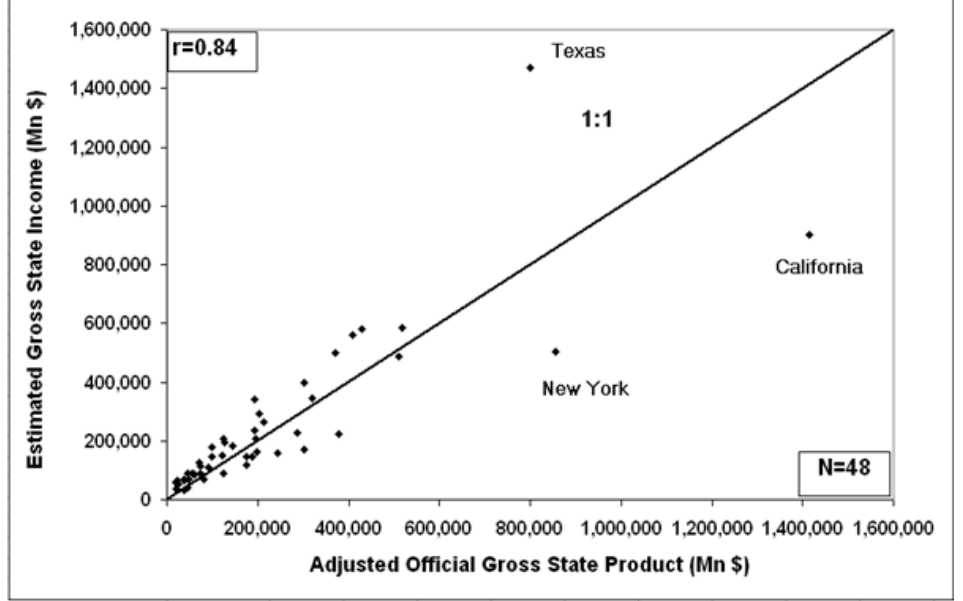
versus Modeled EGSI USi